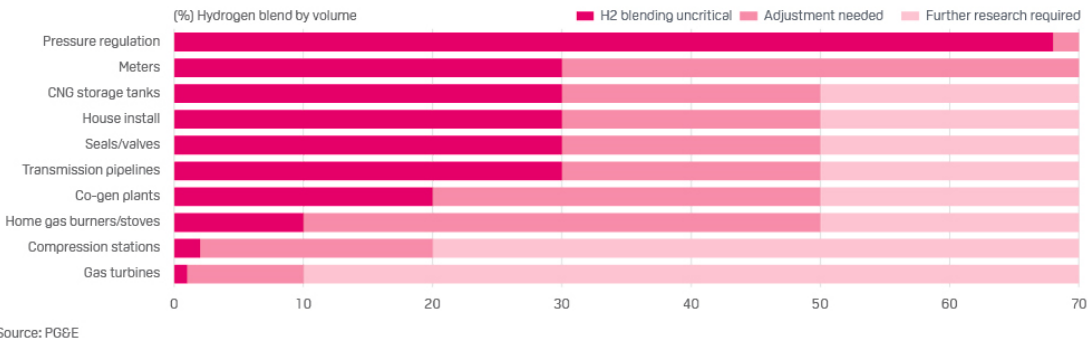
Figure 17. Sensitivity of natural gas infrastructure to hydrogen blending (Reprinted from ref. [91]). The influence of the composition of methane–hydrogen mixtures on the materials of pipelines of the existing natural gas infrastructure was experimentally studied. The results obtained were compared with the literature data [92]. At a pressure of 2 bar in an envi- ronment of 100% hydrogen, a mixture of 20% hydrogen with methane and 100% methane, materials such as polyethylene, steel, cast iron, copper and brass worked. At the same time, there was no negative effect of a mixture of 20% hydrogen with methane on the characteristics of metal and polymer (PE80 pipe polyethylene) materials, as well as on the places of connecting of pipelines. It was concluded that all tested materials of the existing gas transmission pipeline infrastructure are suitable for transporting mixtures of natural gas and hydrogen in the range of hydrogen concentrations up to 20% and pressures up to 2 bars. The possibility of using the existing gas distribution infrastructure for refueling ve- hicles with hydrogen is discussed in the review [93]. Two options are considered: adapta- tion of the existing infrastructure for the use of hydrogen and the direct introduction of hydrogen into natural gas pipeline networks. Hydrogen can be delivered to filling stations as compressed gas or liquid, as well as through pipelines. As one of the possible ways of supplying hydrogen, the supply of natural gas through pipelines to filling stations is also considered, where hydrogen can be produced from it in small-scale methane steam re- formers. This eliminates the need for special transportation of hydrogen to the filling sta- tion. At filling stations, the methane–hydrogen mixture can be used directly as a fuel, or hydrogen can be extracted from it for use in fuel cells. The authors believe that the pipeline transportation of methane–hydrogen mixtures with a hydrogen concentration of 5–15% vol. is technically feasible. However, in each specific case, a preliminary assessment of the cost of such a solution is necessary. It should also be taken into account that the optimal ratio of hydrogen and natural gas is limited by many factors, such as the volume of con- sumption in the market, technical and economic indicators, features of regional networks, etc. The authors come to the conclusion that, most likely, it will be necessary to create a special hydrogen gas distribution infrastructure, consisting of new hydrogen filling sta- tions. The design and construction of such stations will be regulated by international standards. They should include hydrogen storage and cooling systems, compressors and dispensers for refueling vehicles with hydrogen–methane fuel. Japan is already building 100 hydrogen filling stations along highways connecting Japan’s four largest cities. In Ger- many, it is planned to build 400 by 2025 with the production of hydrogen directly at filling stations based on wind and solar energy [94]. When developing mathematical models for the safe addition of hydrogen to existing gas distribution systems, it is important to take into account many factors: the distance over which the gas is transferred, the gas pressure at the inlet, the rate of hydrogen addi- tion to the system, the gas flow rate, the ambient temperature, the geometric parameters of the pipeline, etc. [95,96]. A three-dimensional statistical spiral model of a mixer for